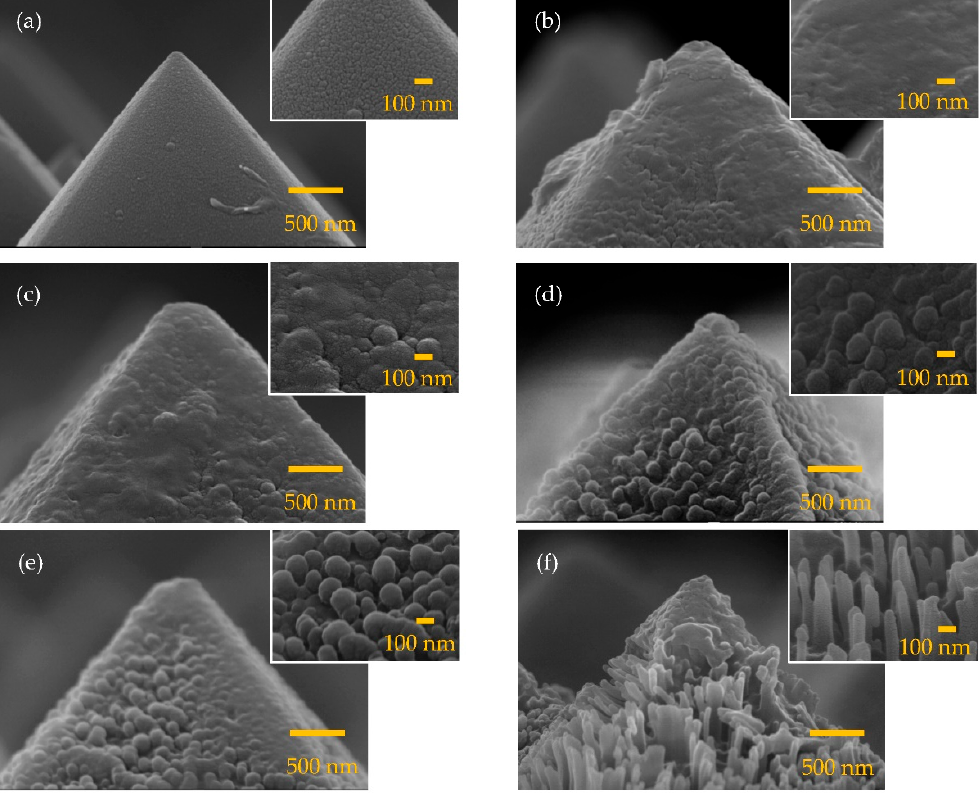
Figure 5. SEM images of the SiN x / Al 2 O 3 -passivated wafers with MACE times of ( a ) 0; ( b ) 1; ( c ) 3; ( d ) 5; ( e ) 7; and ( f ) 9 min. The insets are a close-up view of the wafer surfaces.